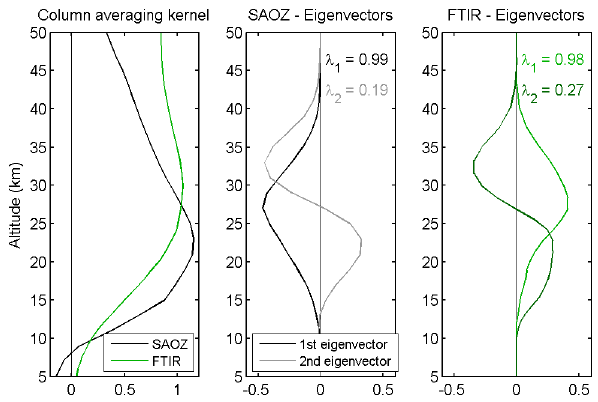
Figure 1: Typical FTIR and SAOZ column averaging kernels (left plot) and leading eigenvectors Fig. 1. Typical FTIR and SAOZ column averaging kernels (left and corresponding eigenvalues (middle plot: SAOZ; right plot: FTIR). The sum of the latter gives plot) and leading eigenvectors and corresponding eigenvalues (mid- the DOFS. dle plot: SAOZ; right plot: FTIR). The sum of the latter gives the